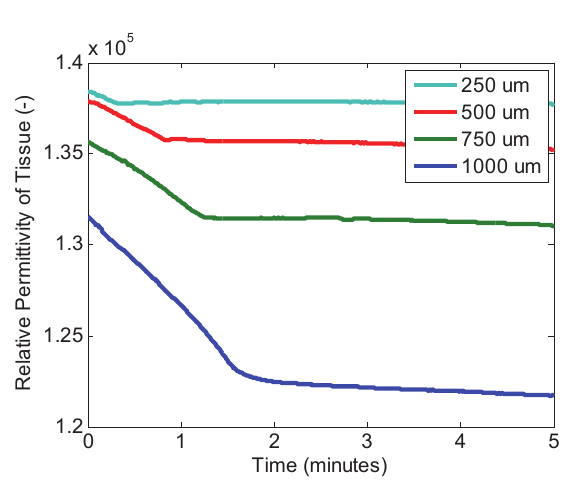
Fig. 19: Measured relative permittivity of alginate hydrogel encapsulated fibroblasts during large strain indentation experiments calculated from eq. 33. Legend denotes final indentation